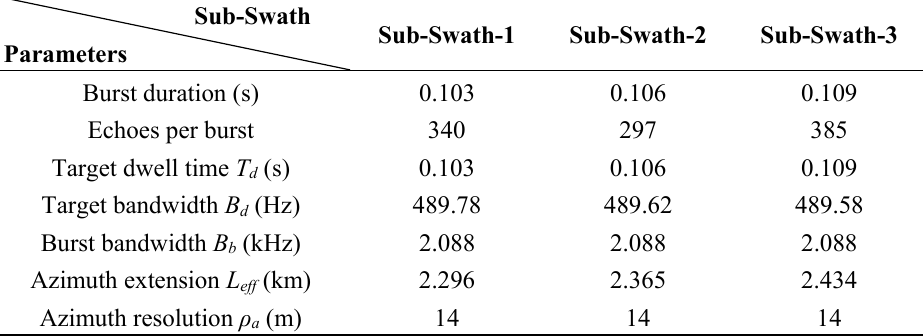
Table 2. Parameters of different sub-swaths in